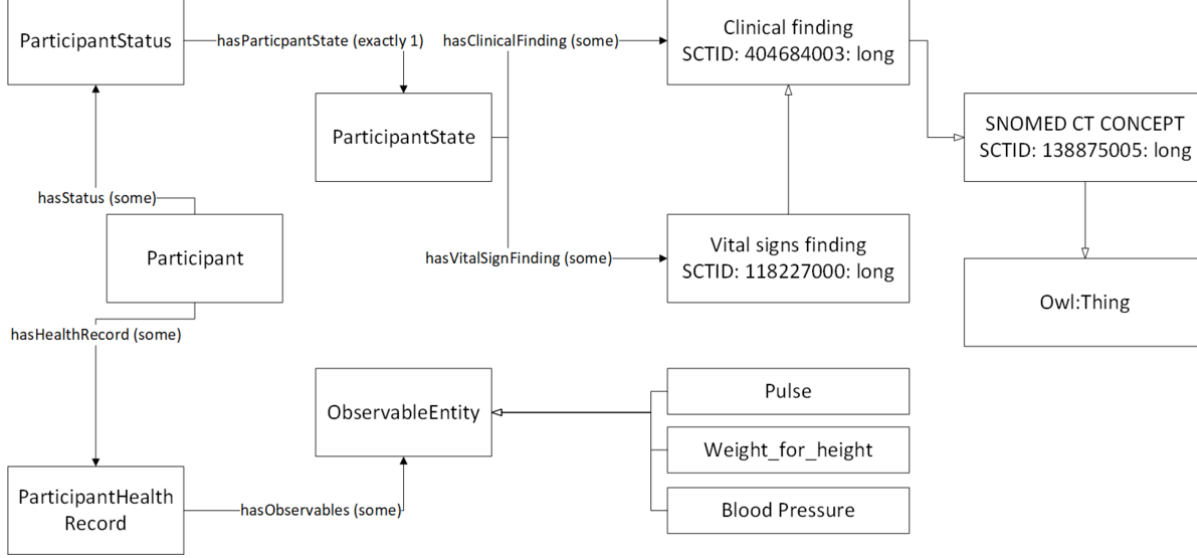
Figure 9. Selected concepts from SNOMED CT Ontology for vital signs, body measurement, and